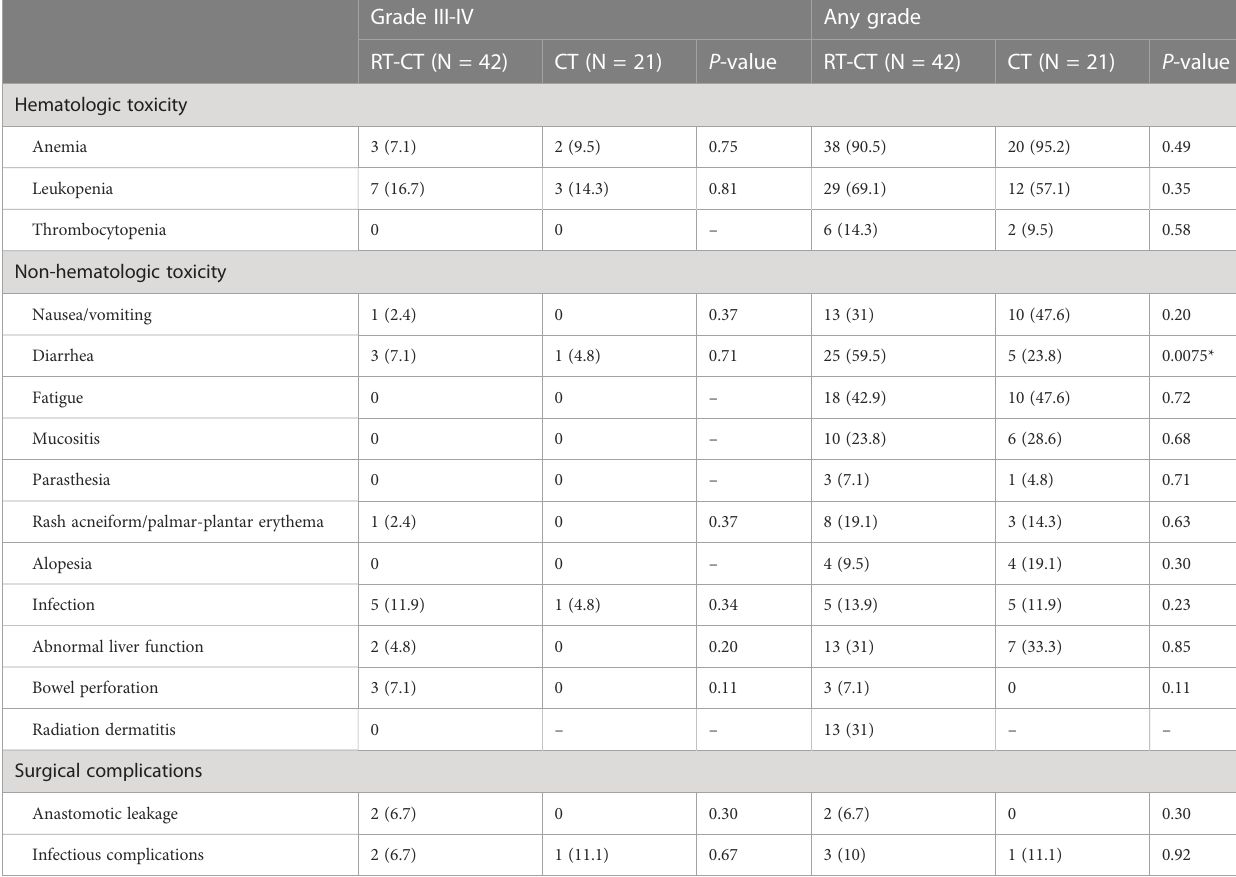
TABLE 5 Adverse effects related to systemic therapy, radiotherapy, and surgical complications in the RT-CT and CT groups.